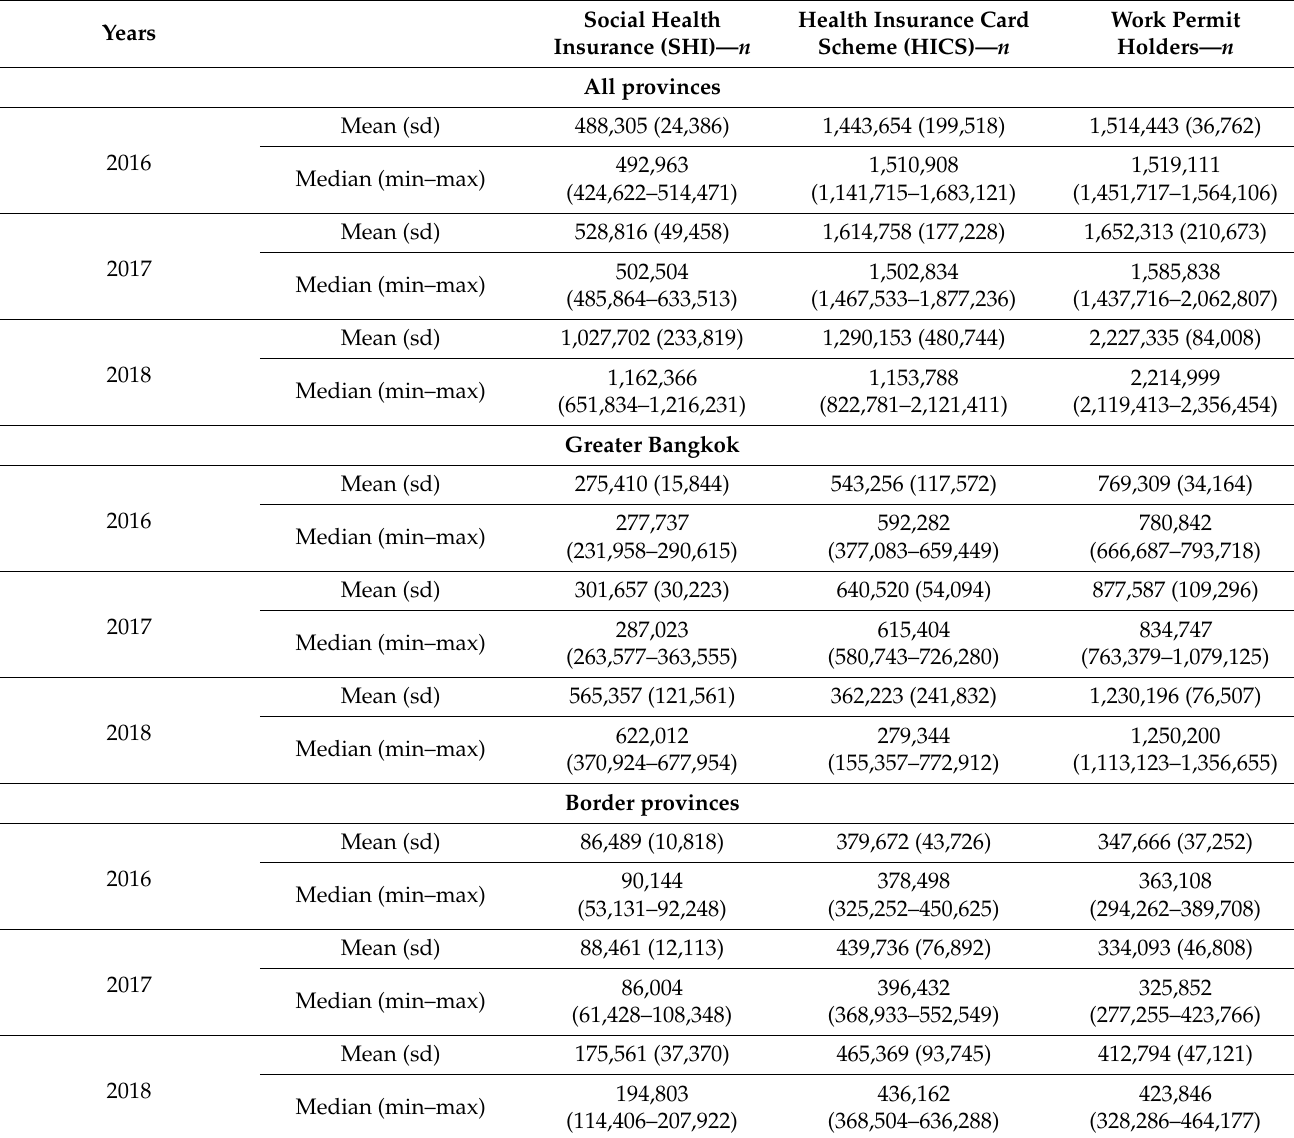
Table 1. Average numbers of migrant insurance coverage,